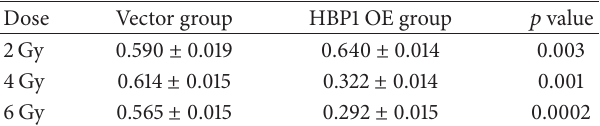
Table 1: Comparison of cell viability of Vector group and HBP1 OE group at 48h after different dose gradient radiation.